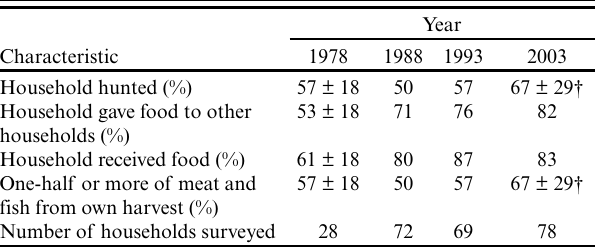
Table 3. Household hunting, harvesting, and food sharing characteristics. Source: North Slope Borough 1978, 1988, 1993, and 2003 ( unpublished data ).